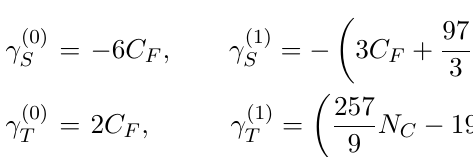
implemented in POWHEG , a (cid:2) that the operator contributes at tree level, but has been neglected be- cause of the reasons explained in the text, while a (cid:0) indicates that the operator does not contribute at leading